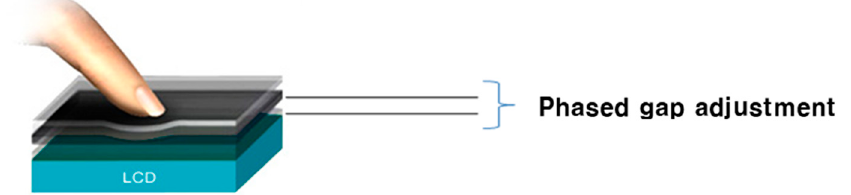
Figure 9. Phased gap adjustment corresponding to the different depth of water.